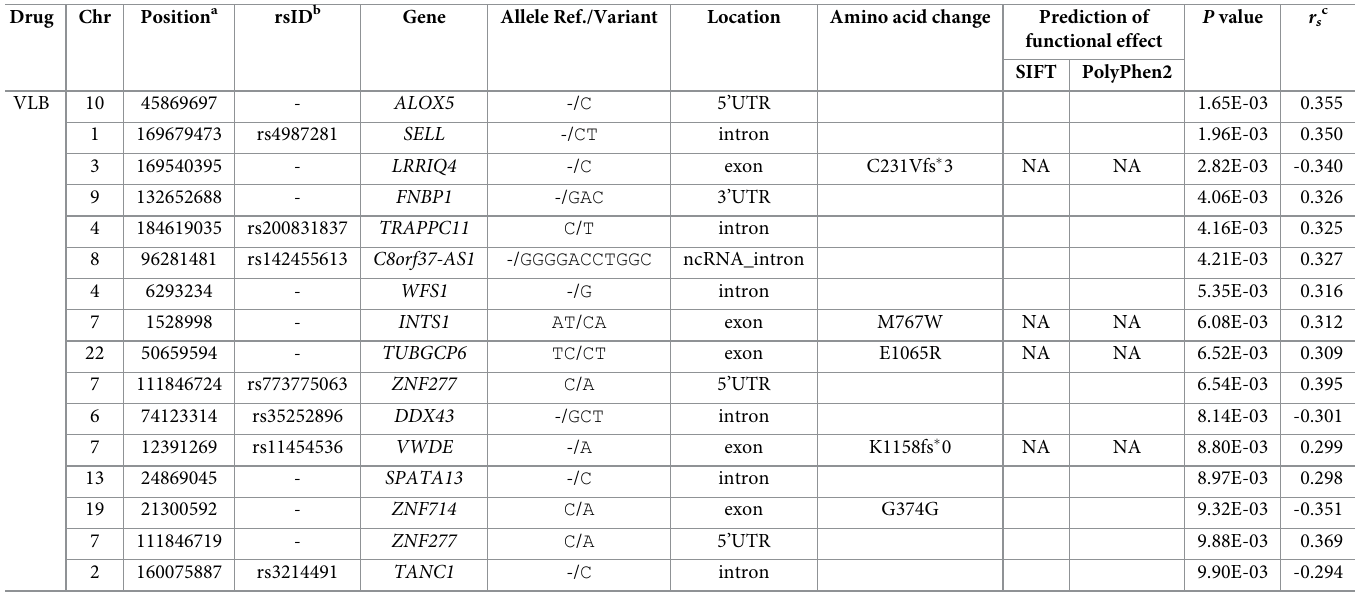
Table 9. Variants associated with chemosensitivity to VLB (P < 0.01), as identified among 79 xenografts.